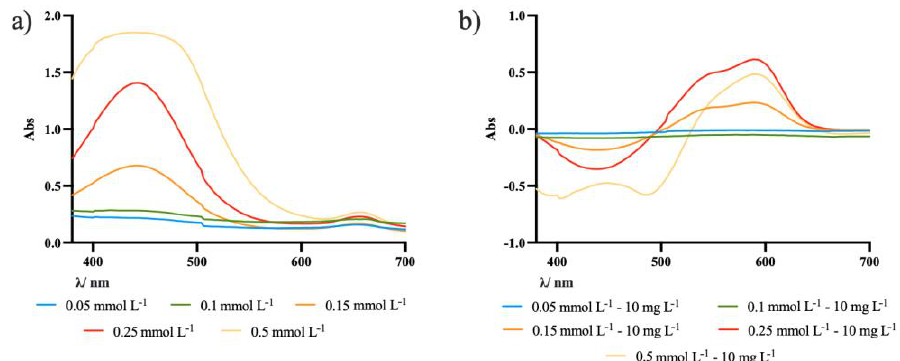
Figure 2. Graphical representation of UV-Vis spectra of: ( a ) CH-Ul membrane with different con- centrations of ECR; ( b ) CH-Ul membranes after immersion on 10 mg L −1 Al(III) solution. trations of ECR; ( b ) CH-Ul membranes after immersion on 10 mg L − 1 Al(III) solution. Afterwards, the membranes with different concentrations of ECR were immersed in a solution of 10 mg L − 1 of Al(III) (Figure